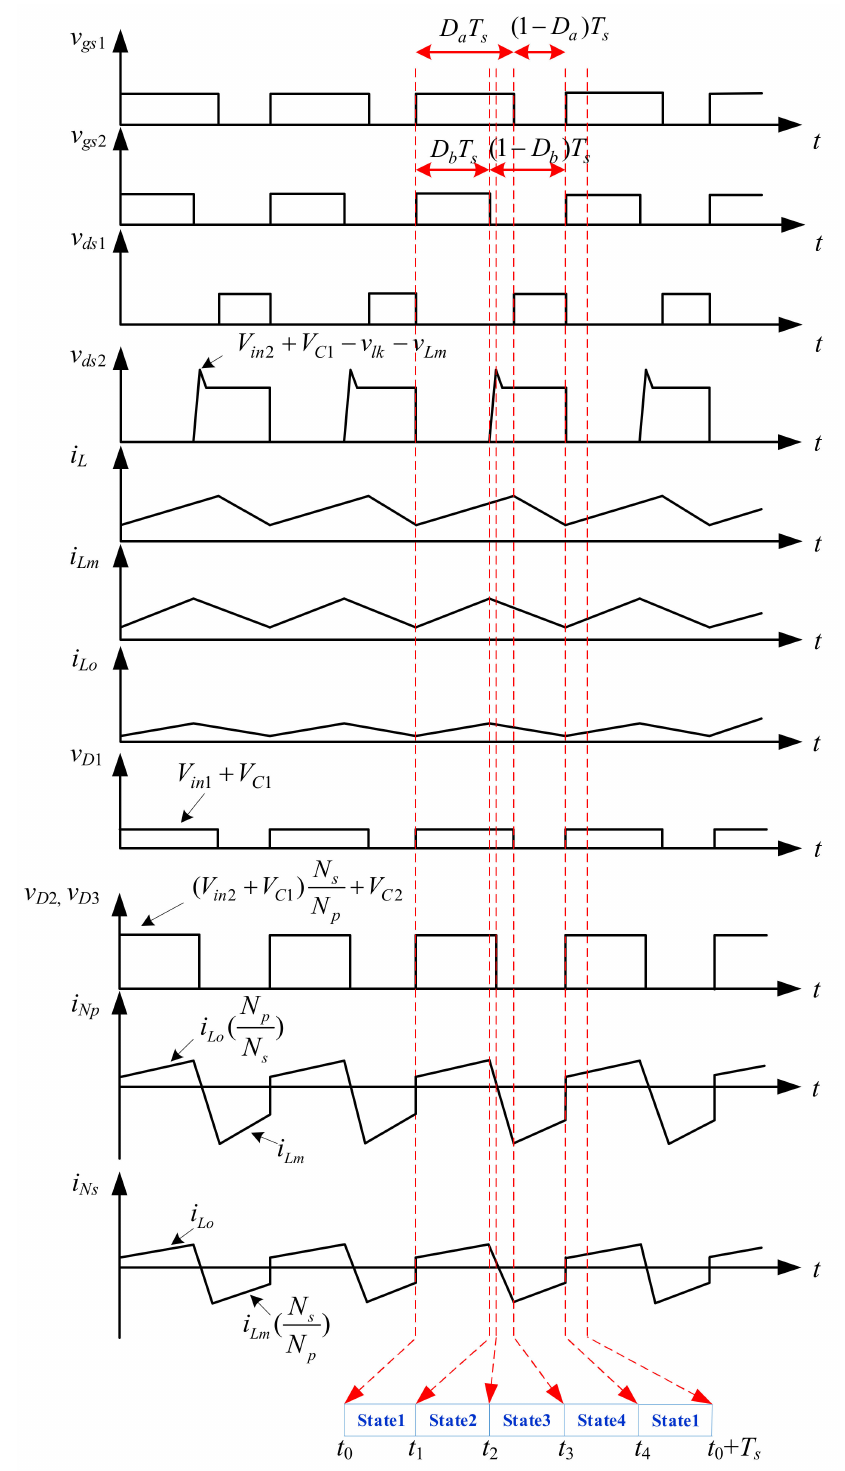
Figure 6. Illustrated waveforms relevant to the proposed isolated MISOC